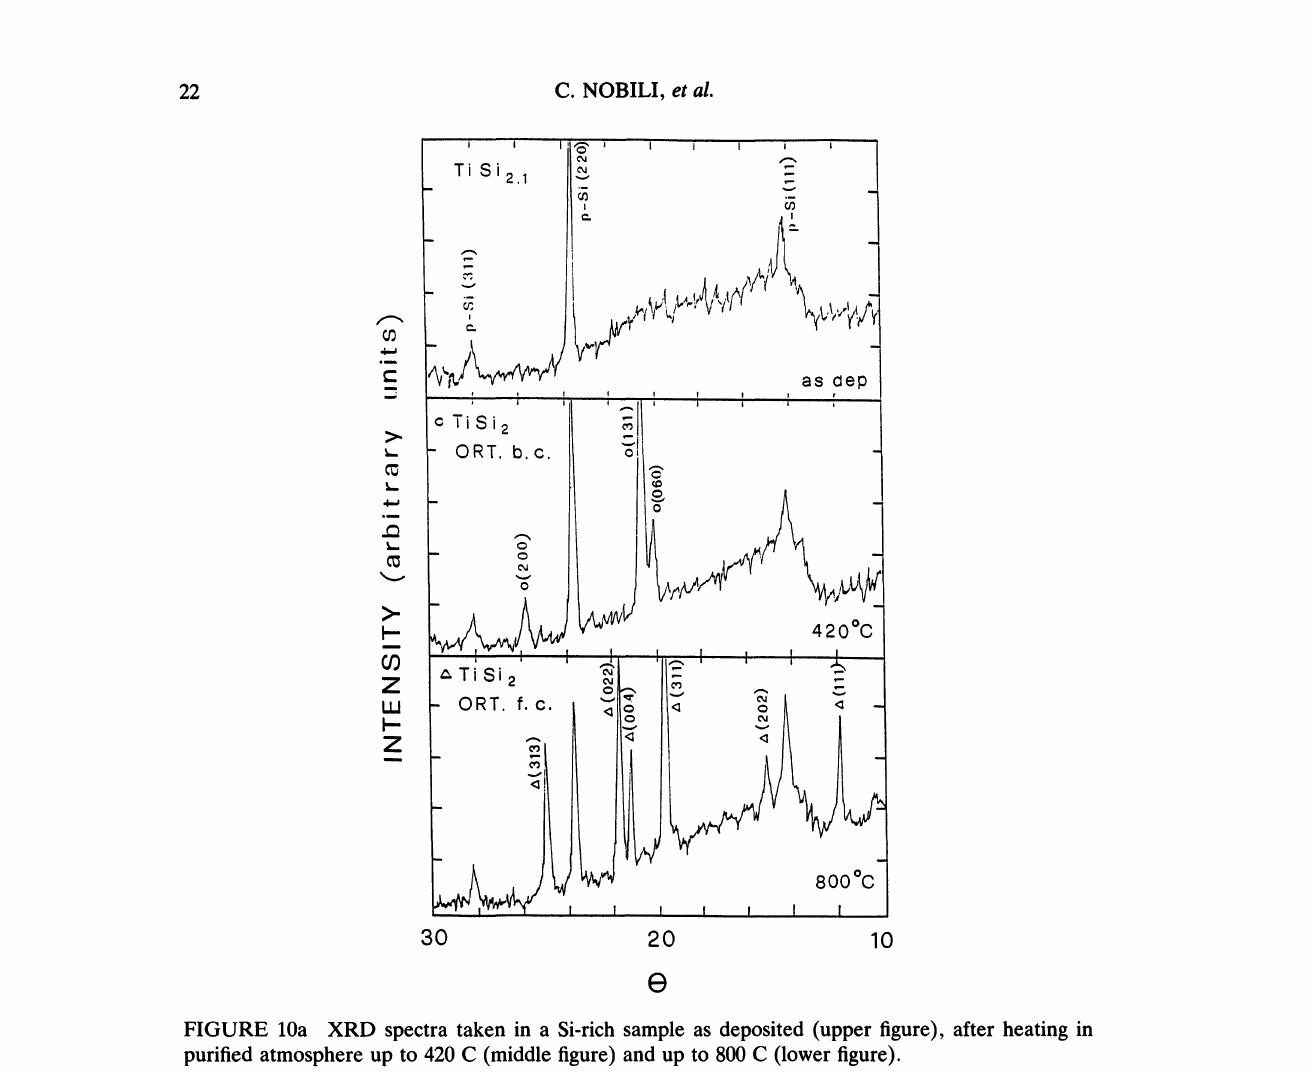
FIGURE 10a XRD spectra taken in a Si-rich sample as deposited (upper figure), after heating in purified atmosphere up to 420 C (middle figure) and up to 800 C (lower